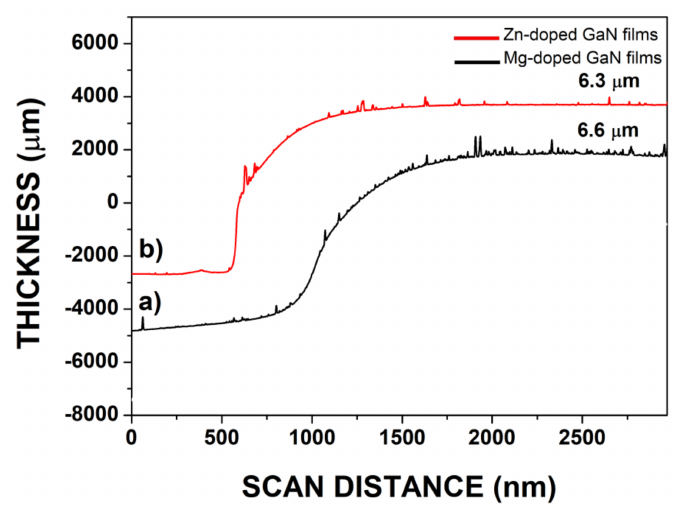
Figure 6. Surface profilometer reading to measure the thickness of the films deposited by radio- frequency magnetron sputtering: (a) Mg-doped GaN films; (b) Zn-doped GaN